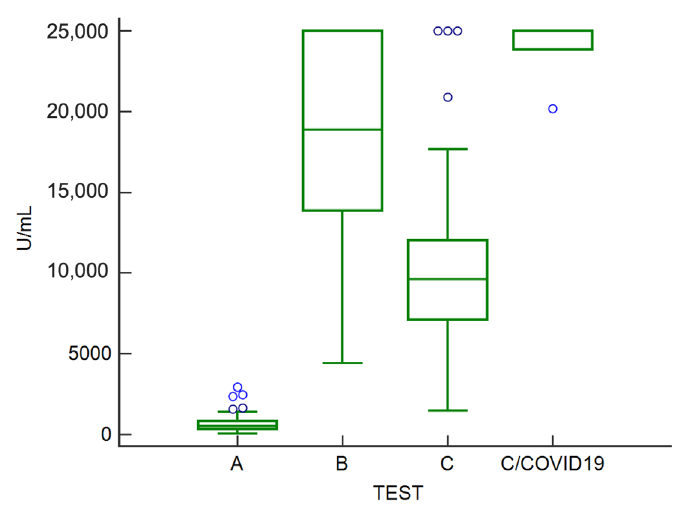
Figure 1. Box-plot showing the distribution of antibody concentration in analyzed subjects before (test A) and on average one (test B) and four months (test C for naïve subjects, test C/COVID19 for infected subjects) after the third dose. Blue circles represent the outliers. (Test A: prior booster; Test B: one month after booster; Test C: four months after booster).